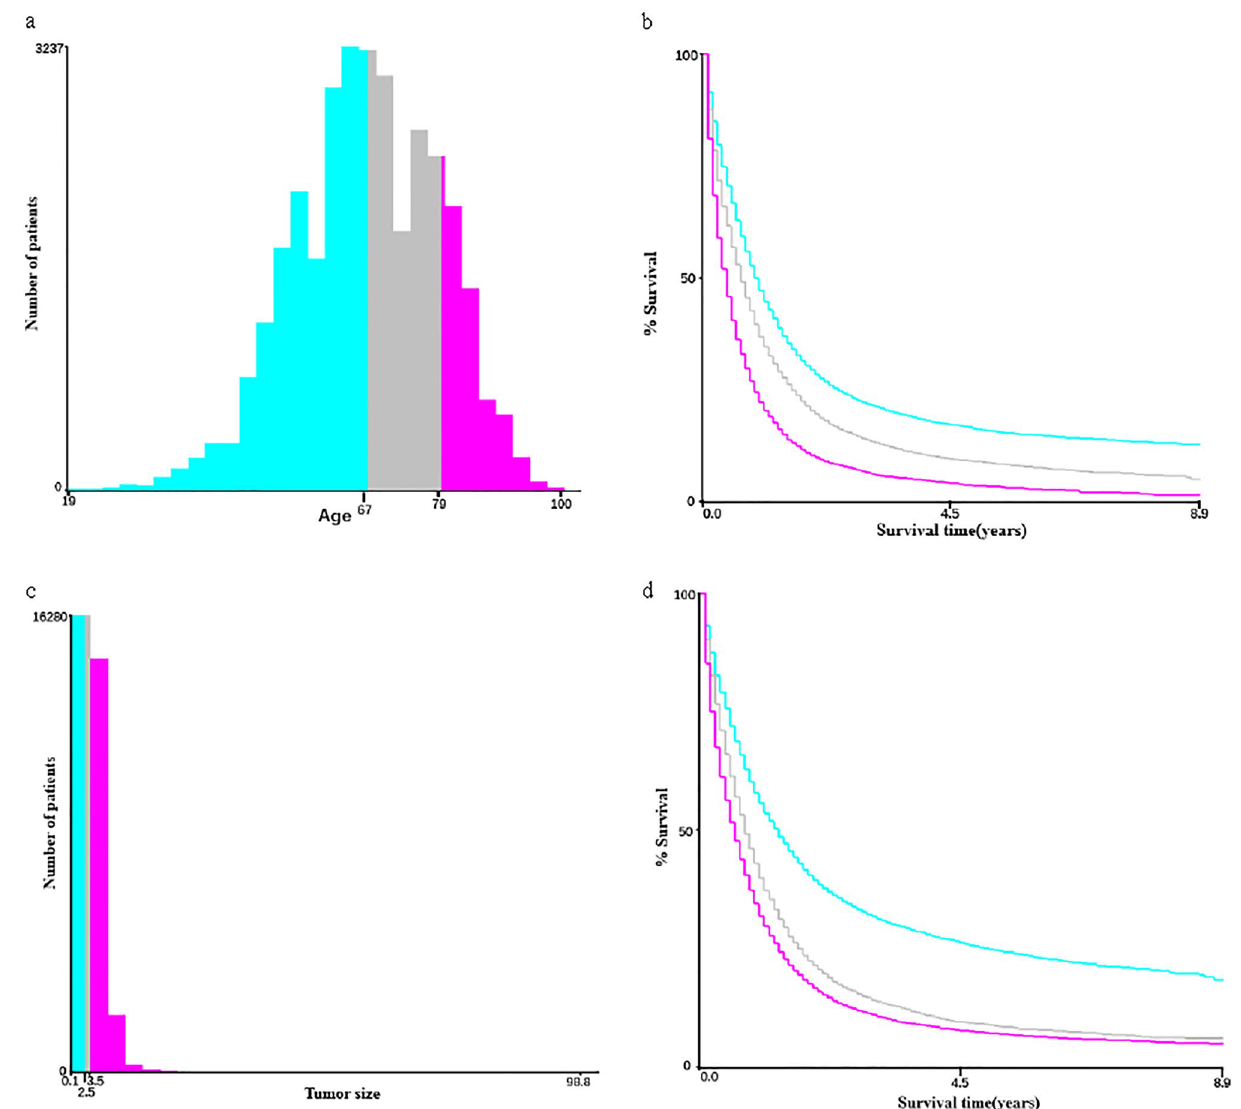
Figure 2. Patient numbers and survival curves generated by X-tile software. ( a ) Number of patients at different ages of diagnosis. ( b ) Survival curves for three age ranges. ( c ) Number of patients with different tumor sizes. ( d ) Survival curves for three tumor size